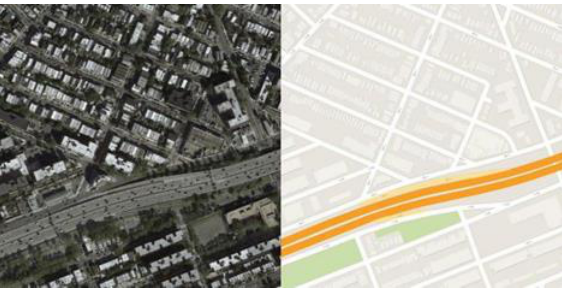
Figure 1. A pair of training data that render the green space as a square for aesthetic reasons.